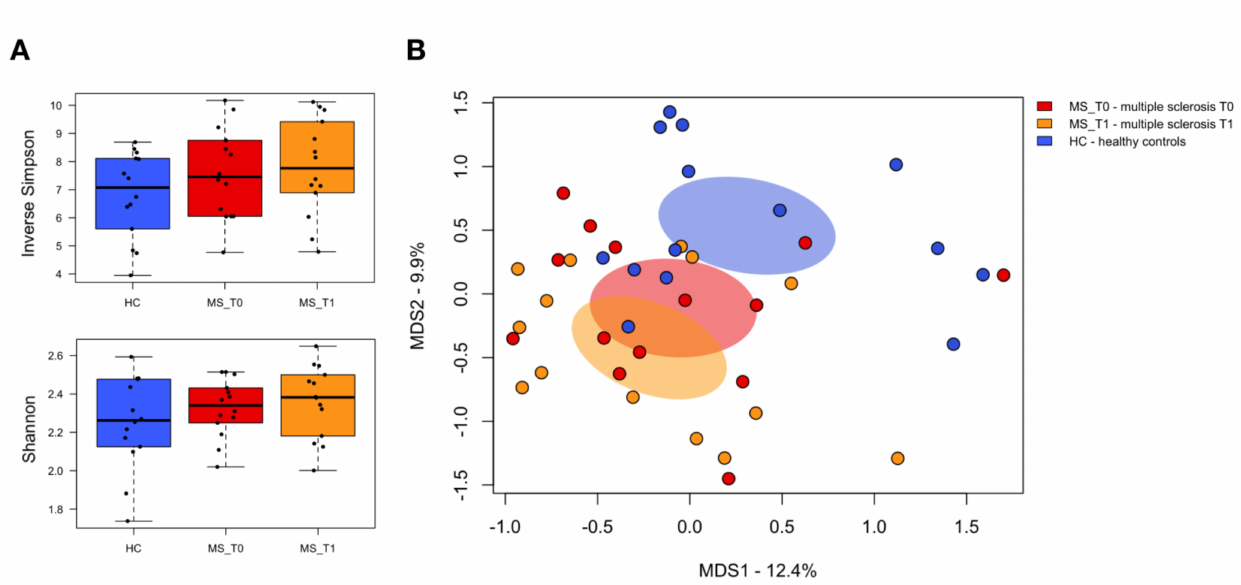
Figure 1. The gut microbiota diversity of multiple sclerosis patients before and after the rehabilitation program compared to healthy subjects. ( A ) Boxplots showing the distribution of alpha diversity, measured using the Inverse Simpson (top) and Shannon (bottom) indices, for the gut microbiota of multiple sclerosis patients before (MS_T0, red) and after the rehabilitation program (MS_T1, orange), as well as for age- and sex-matched healthy subjects across Italy (HC, blue). ( B ) Principal Coordinates Analysis (PCoA) of the gut microbial communities, based on the Jaccard similarity index. Significant segregation between study groups was found ( p < 1 × 10 − 4 , permutation test with pseudo-F